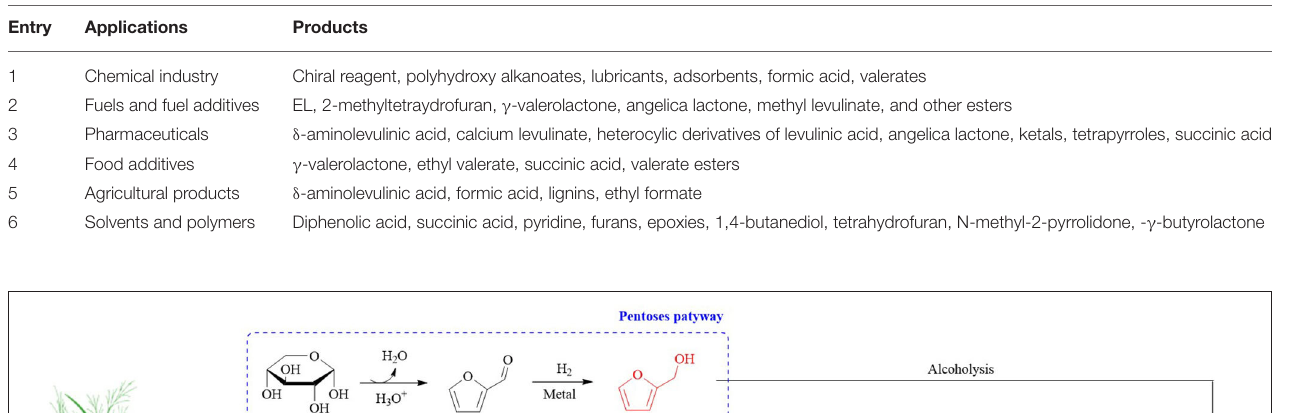
TABLE 1 | Potential alkyl levulinates applications.